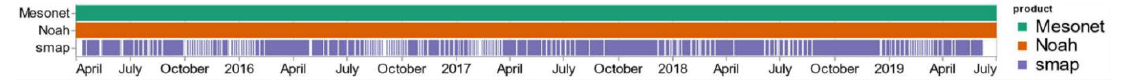
Figure 3. Temporal coverage of SMAP, Noah, and Mesonet soil moisture products used in this study. White spaces represent data gaps. Table 2. Sample sizes of 6 a.m. and 6 p.m. Seasonal TC triplets used in this study. Type